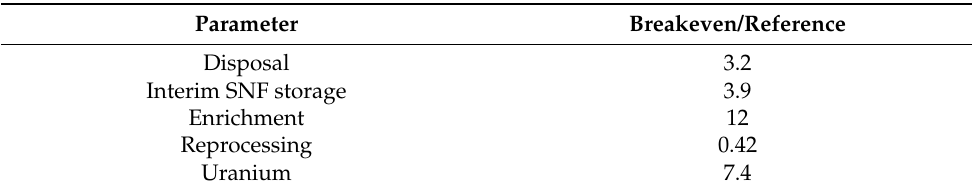
Table 5. Changes to selected parameters (with respect to the reference cost) needed to reach the uranium breakeven price [42].